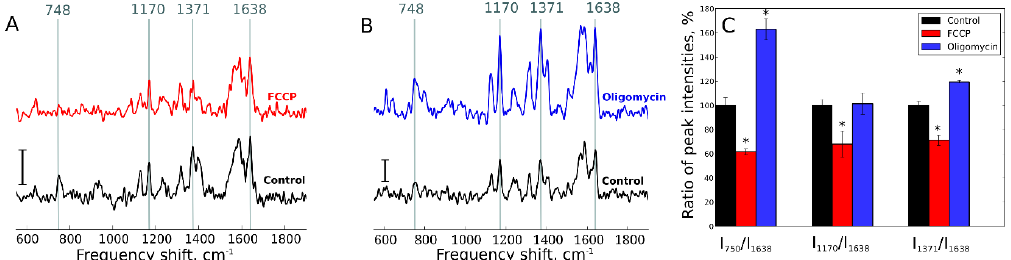
Figure 8. SERS study of functioning mitochondria. ( A , B ): SERS spectra of mitochondria suspension placed on Ag nanostructured surface under conditions ensuring electron transport in ETC and ATP synthesis (black spectra) and after FCCP or oligomycin applications (red and blue spectra, respectively). ( C ): ratios of chosen peak intensities under control conditions, depolarization of the inner mitochondrial membrane and proton gradient dissipation (FCCP) and inhibition of ATP synthesis (oligomycin). Reprinted from [268] with permission by Creative Commons